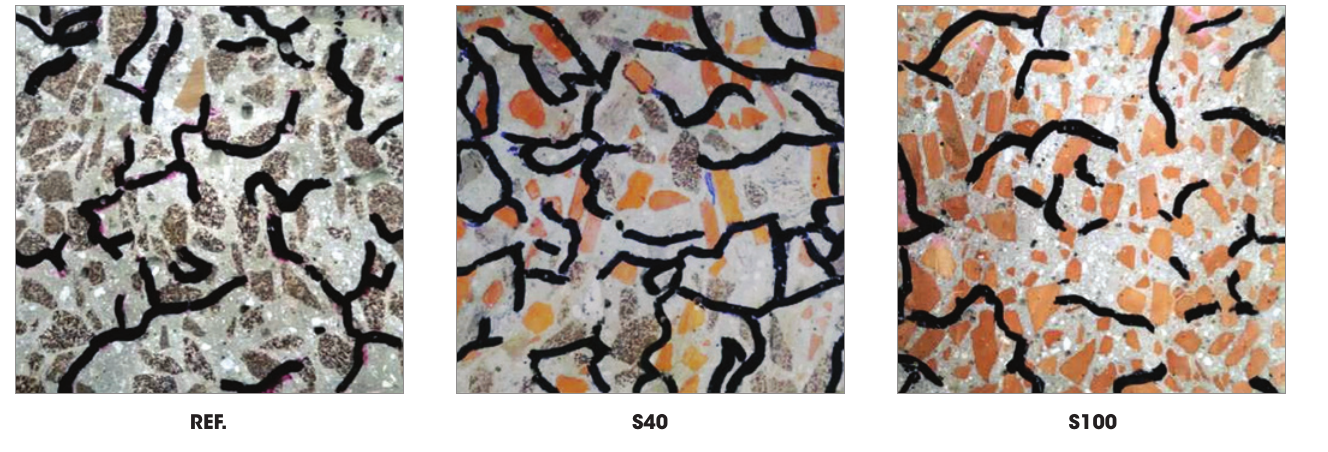
Specimens after the evaluation of explosive spalling (temperature: 925°C)